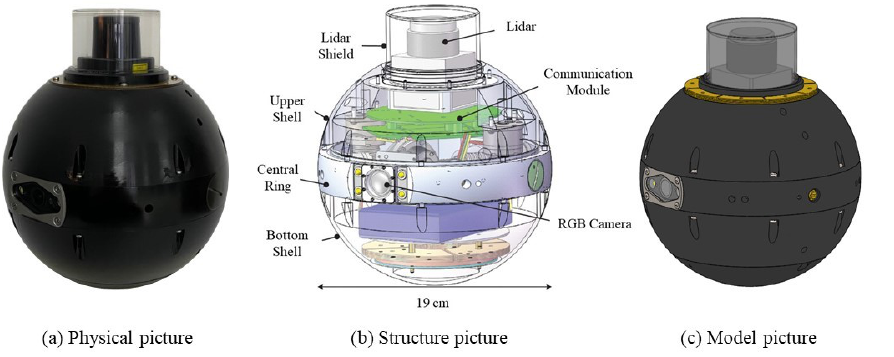
Figure 5. Physical platform and simulated model used in the experiment.